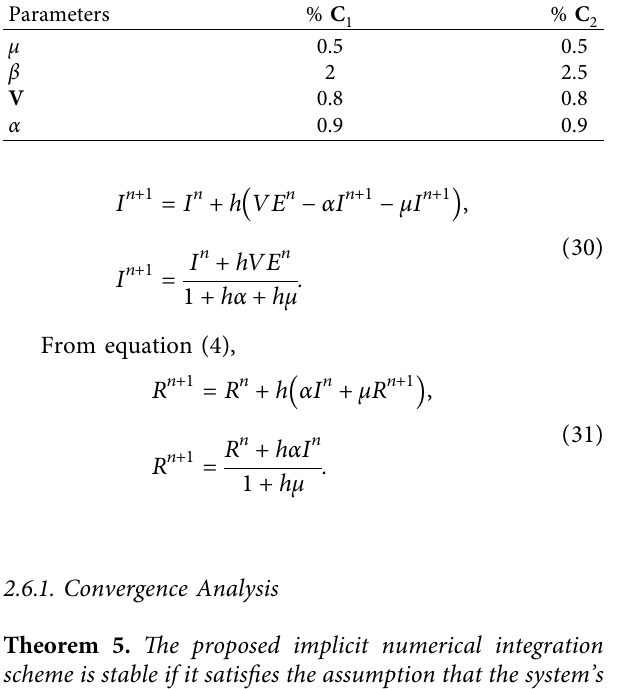
Table 1: Values of parameters